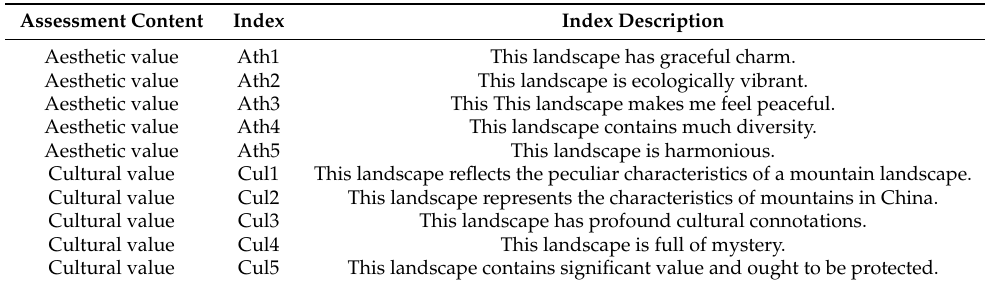
Table 1. Mountain landscape value assessment scale (Ath means aesthetic value and Cul means cultural